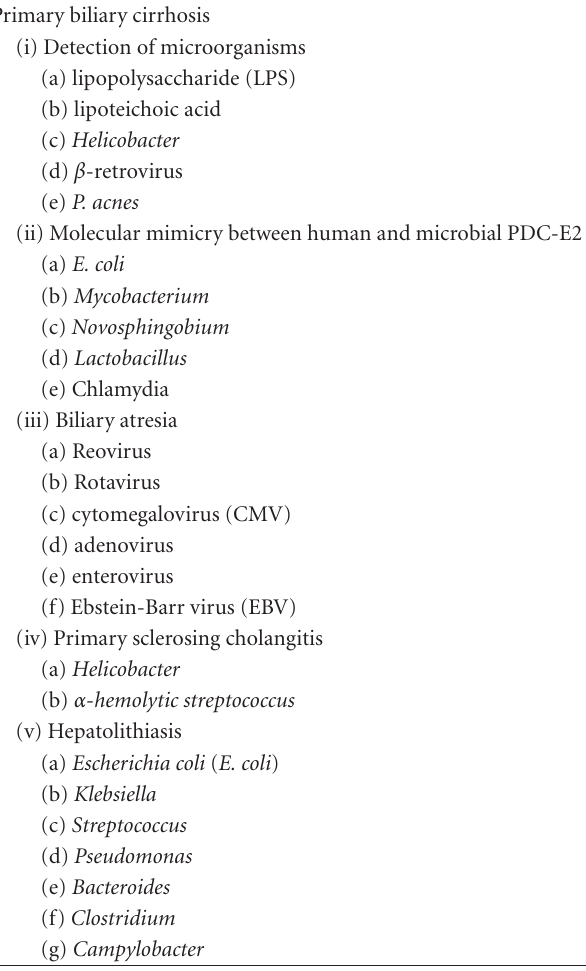
Table 1: Bacteria and viruses possible etiological of biliary diseases. Primary biliary